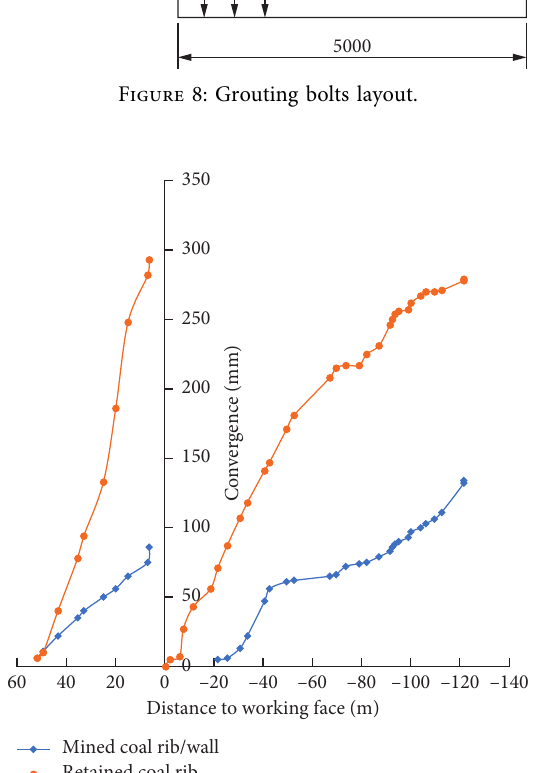
Figure 9: Curve of retained roadway ribs